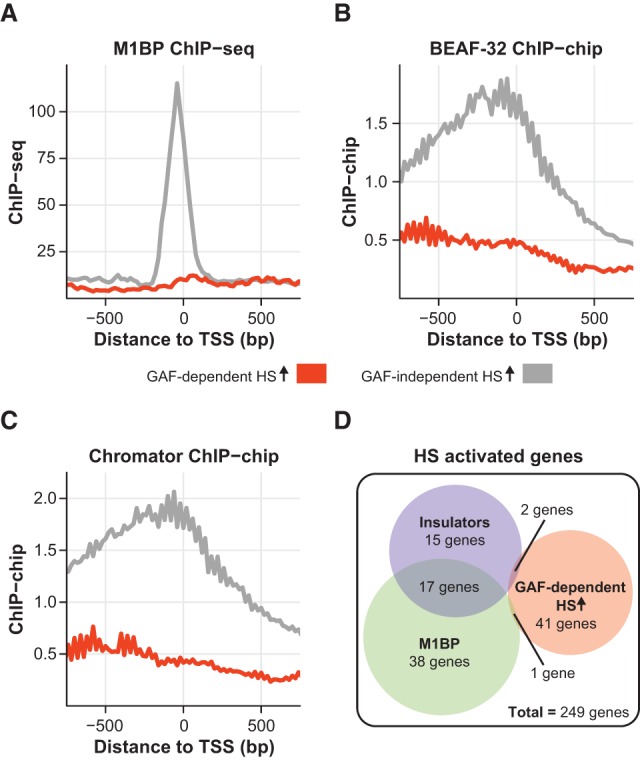
Insulator proteins and M1BP are enriched in the promoter region of HS-activated genes with GAF-independent induction. (A–C) M1BP ChIP-seq (A), BEAF-32 ChIP–chip (BEAF-HB antibody) (B), and Chromator ChIP–chip (BR antibody) (C) signal between −750 and +750 bp to the TSS (in 20-bp bins) of genes with GAF-dependent (n = 44) or GAF-independent (n = 199) HS activation (HS ↑). (D) Venn diagram showing the overlap between HS-activated genes with GAF-dependent activation and genes bound by M1BP or both insulator proteins (BEAF-32 and Chromator; only genes with insulator binding detected by both antibodies for these two proteins were considered) within ±1 kb of the TSS.